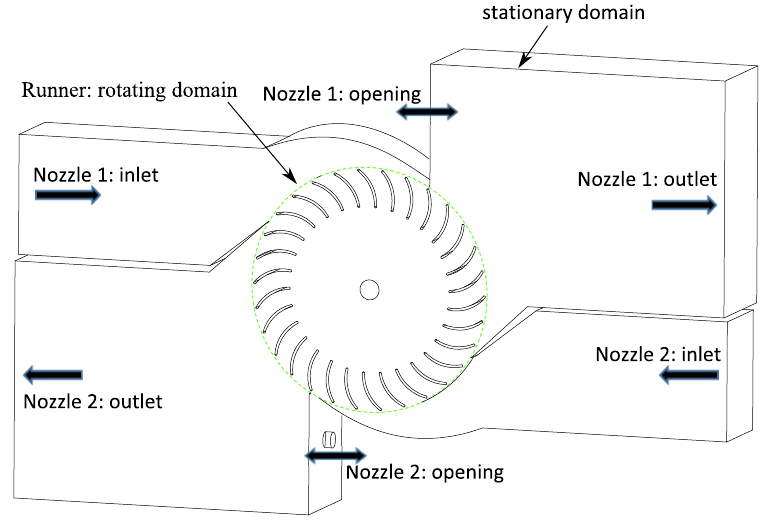
Figure 4. Schematic of the computational domain of the double-nozzle